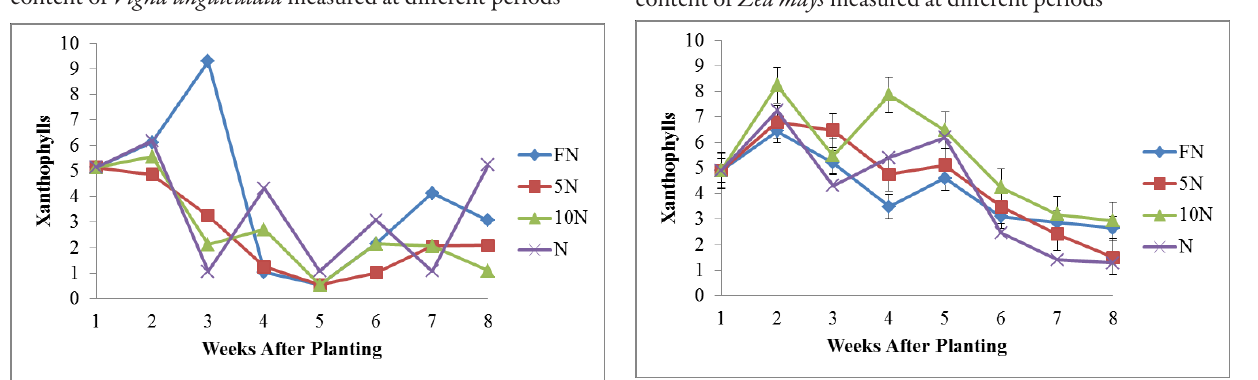
Fig. 5a. The effect of nitrogen nutritional stress on the xan- thophyll content of Vigna unguiculata measured at different periods